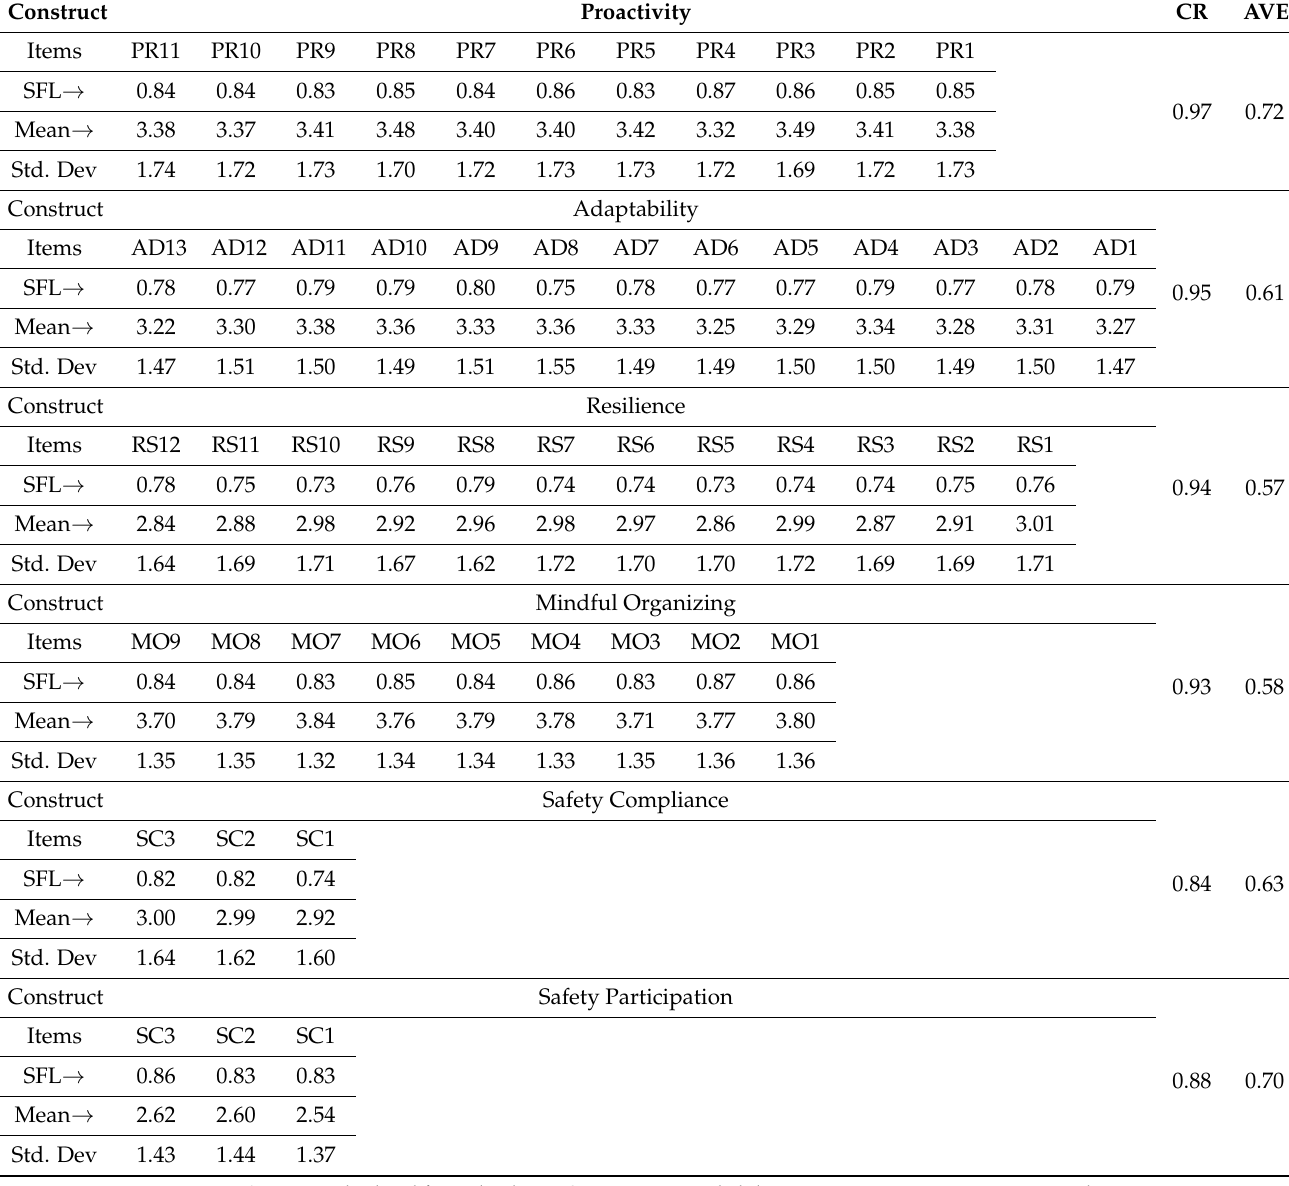
Table 1. Convergent validity